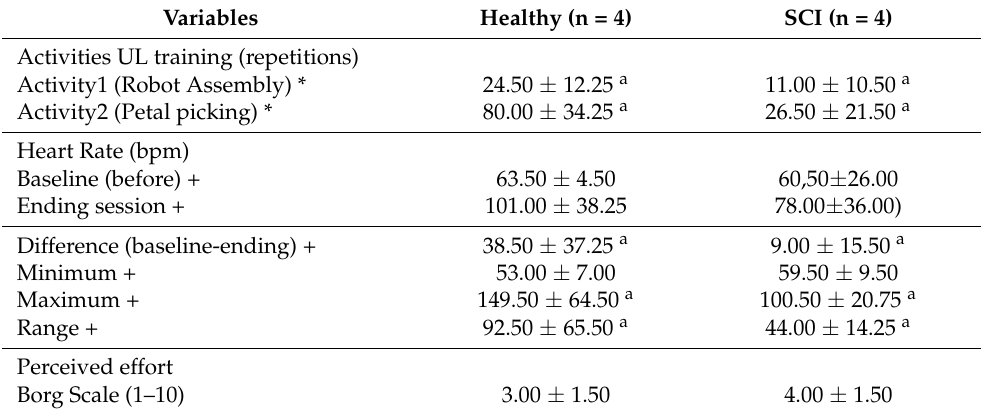
Table 2. Outcome variables measured within the experimental session number 6 for healthy and SCI patients.